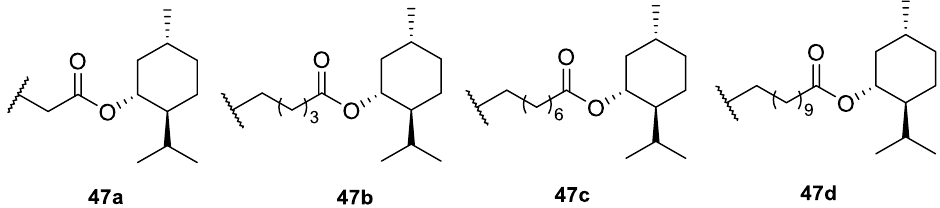
Figure 21. Structures of acyl hydrazones 47 of doxorubicin hydrochloride with ( − )-menthol moiety. Bernhardt et al. [85] also tested menthol derivatives for antiproliferative activity in human 518A2 melanoma and HL-60 leukemia cells. They synthesized dichloridoplati- num(II) complexes 48 and 49 with several terpenes, including four isomers of menthol moieties, namely ( − )-menthol ( 48a – g ), (+)-menthol ( 48h – j ), (+)-neomenthol ( 48k – m ) and ( − )-neomenthol ( 48n ) and their derivatives (Figure 22). In melanoma cells, the propane- 1,2-diyl spaced with a terpene moiety of ( − )-menthol derivative 48b and (+)-neomenthol derivative 48l displayed growth inhibition at an IC 50 < 4 μM , which is 10-fold lower than seen with cisplatin (Table 1). Furthermore, presented terpene complexes ( 48 , 49 ) were tested for antiproliferative activity in human HT-29 colon cells. Greater and more persis- tent growth inhibition in HT-29 colon cancer cells upon long-term exposure is induced by the ( − )-menthyl ester complexes with 2,3-diaminopropanoate ( 49a ) and 2,4-diaminobuta- noate ( 49b ) ligands compared with the 6-(aminomethyl)nicotinate analogue 48a . The ( − )- menthoxyisopropyl ester ( 48c ) was the most efficacious against all of the tumor cell lines tested.